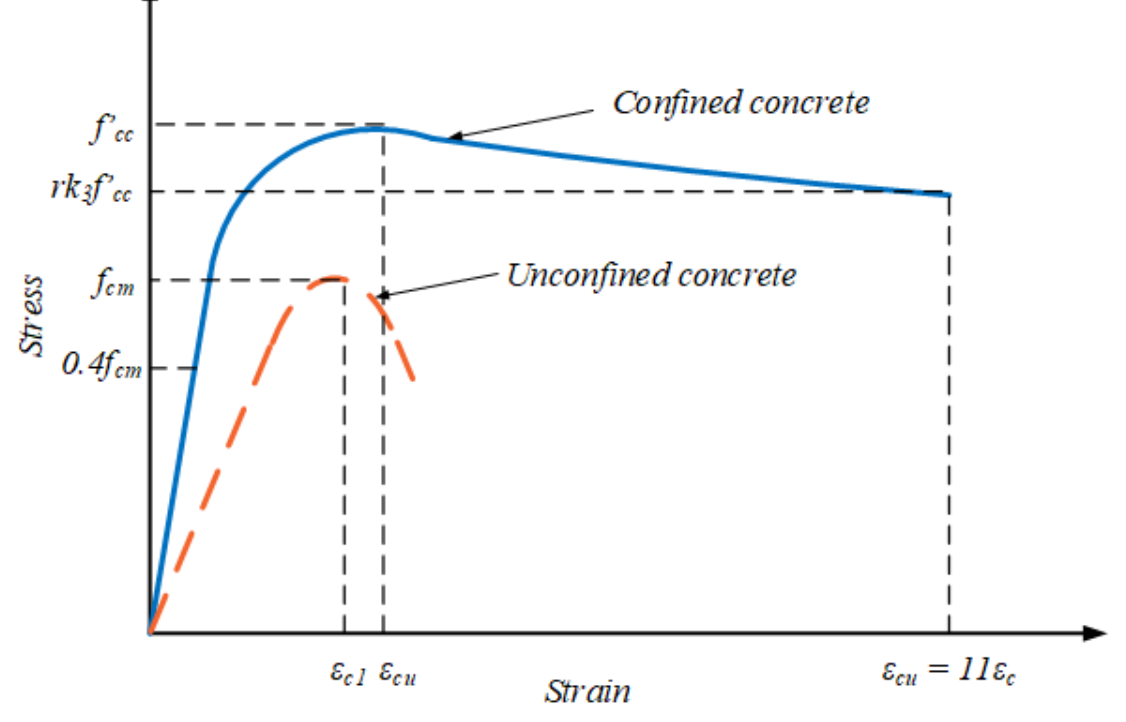
Figure 4. CDP model for concrete (stress versus strain).